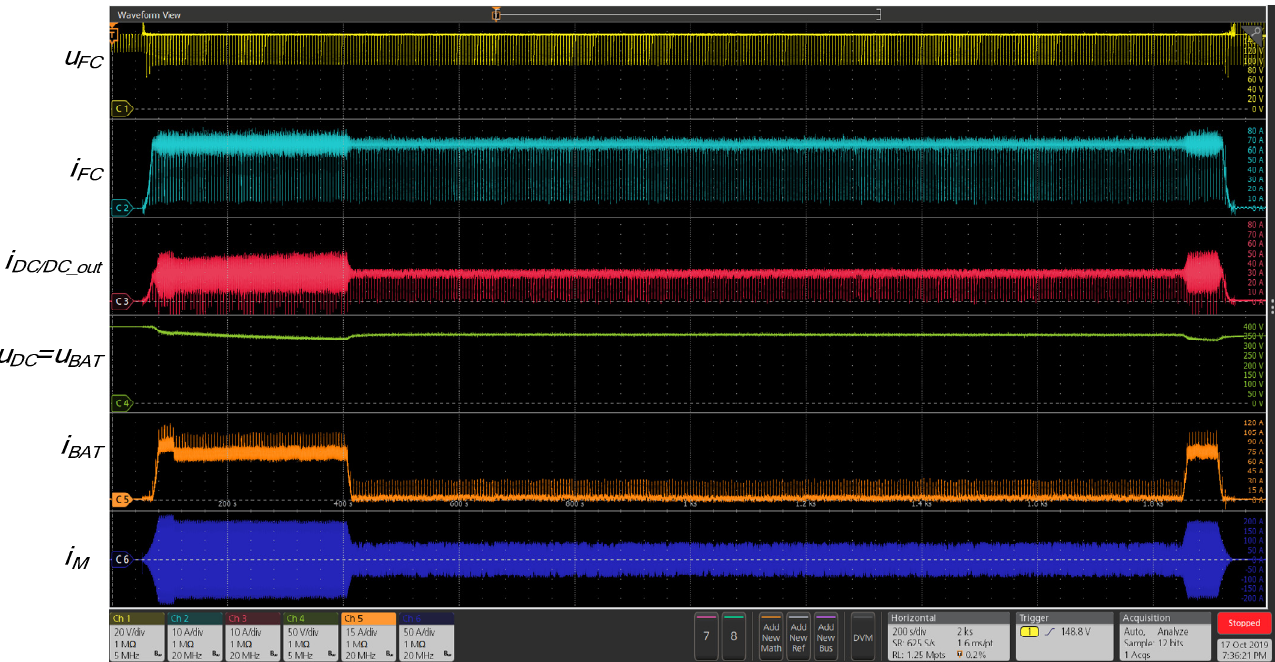
Figure 10. Selected waveforms from the stationary condition tests during realization of mission profile registered by an oscilloscope.